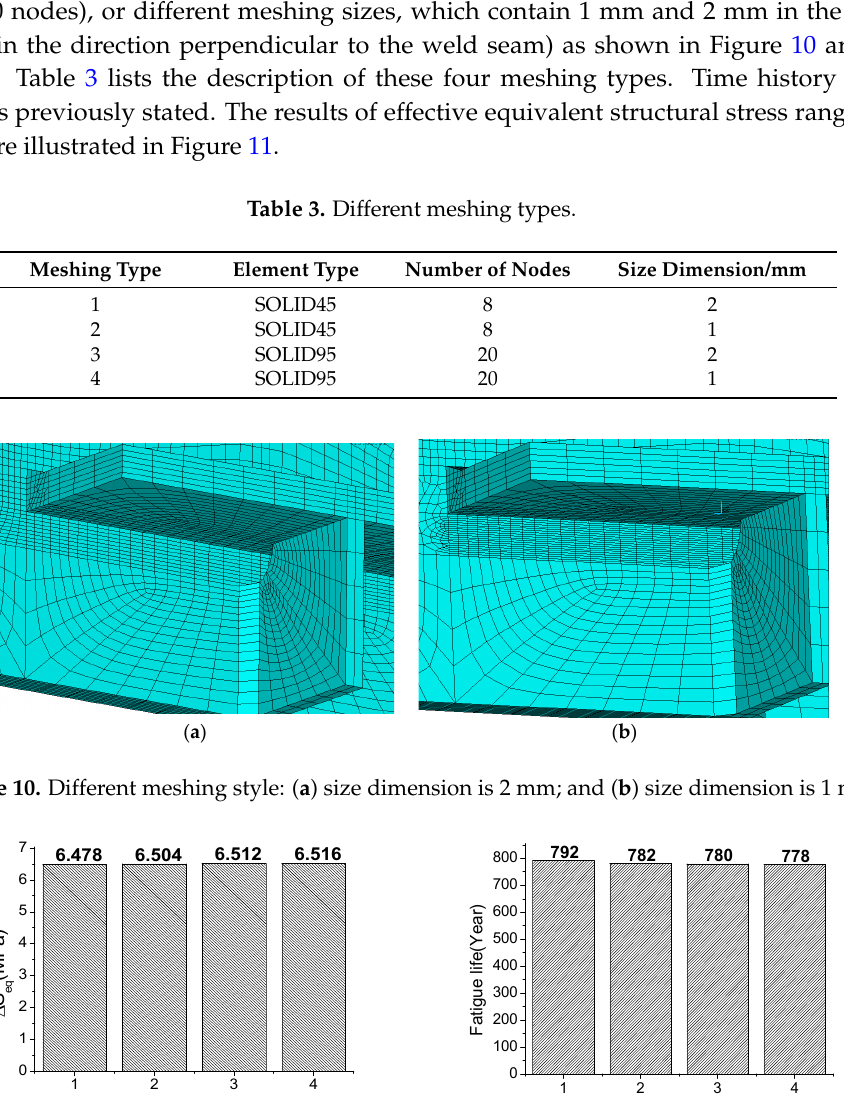
Table 2. Fatigue assessment result based on equivalent structural stress method.